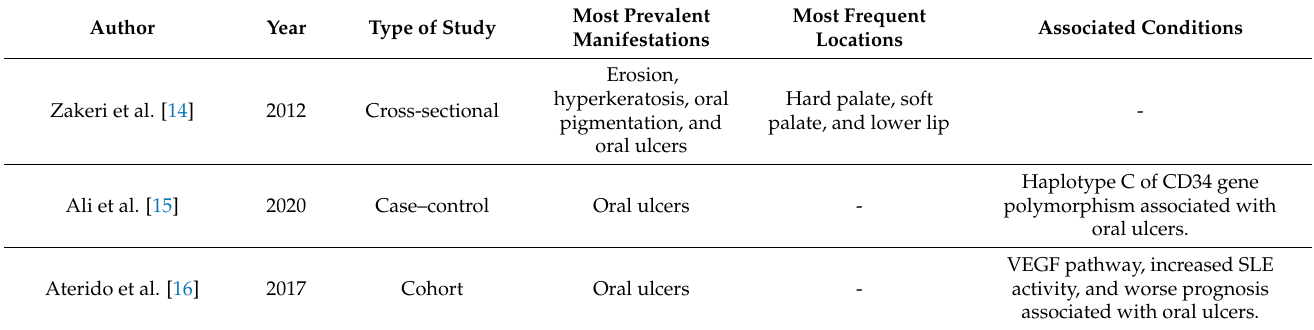
Table 2. Description of the differentiated